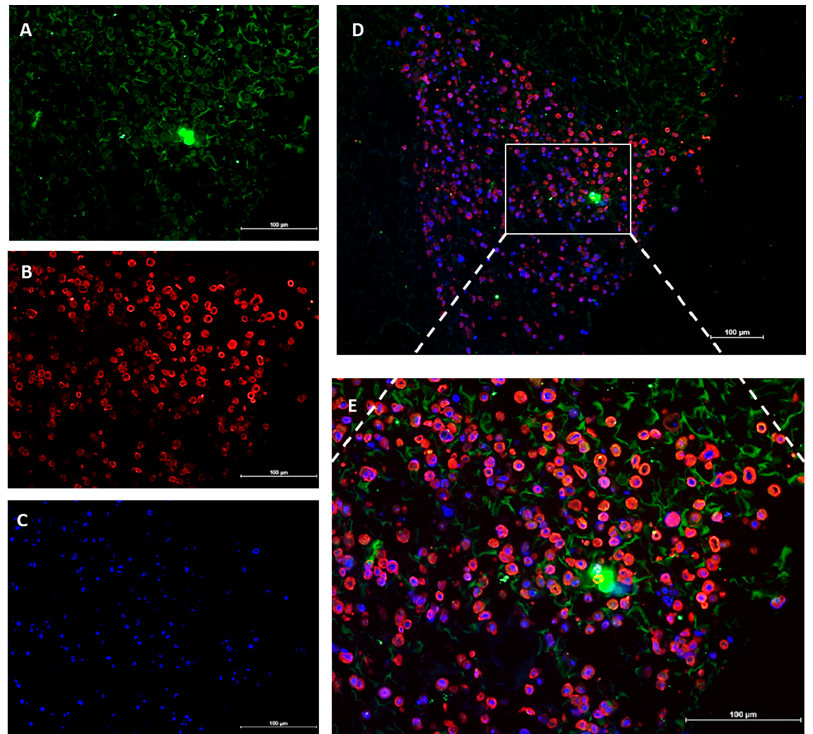
Figure 4. The top view of the cell-seeded collagen scaffold immunostained with ( A ) anti-Col type I antibody (green) as the fibroblast marker and ( B ) anti-cytokeratin 14 antibody (red) as the marker of RECs. ( C ). The cell nuclei were counter-stained with 4`,6-diamidino-2-phenylindole (DAPI) (blue). ( D ) Merged image 10× and ( E ) 20×. ( A ). The anti-Col type I antibody was found to bind to the scaffold in addition to the fibroblasts. The intense green color located almost centrally ( A ) formed due to the accumulation of green fluorescence in unknown debris.